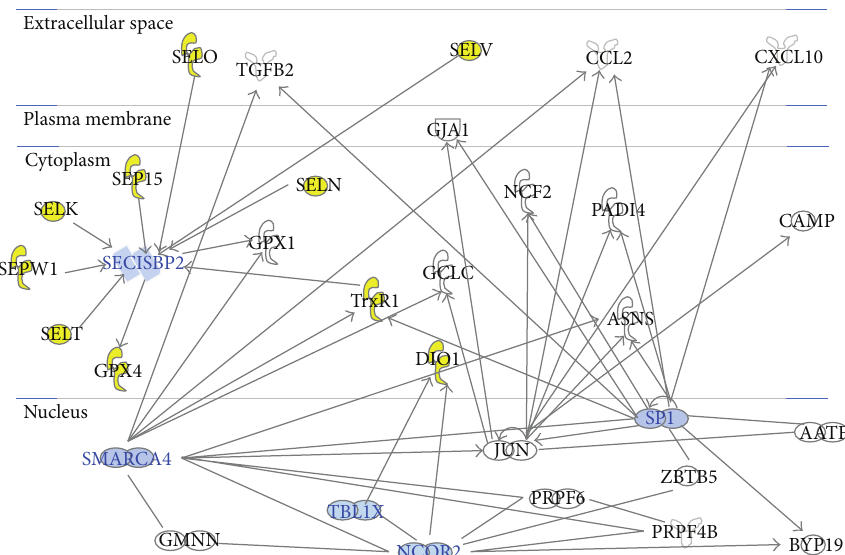
Figure 2: Network analysis: down- and upregulated genes are evidenced by yellow symbols, HUB nodes by cyan symbols, whereas all other genes by white